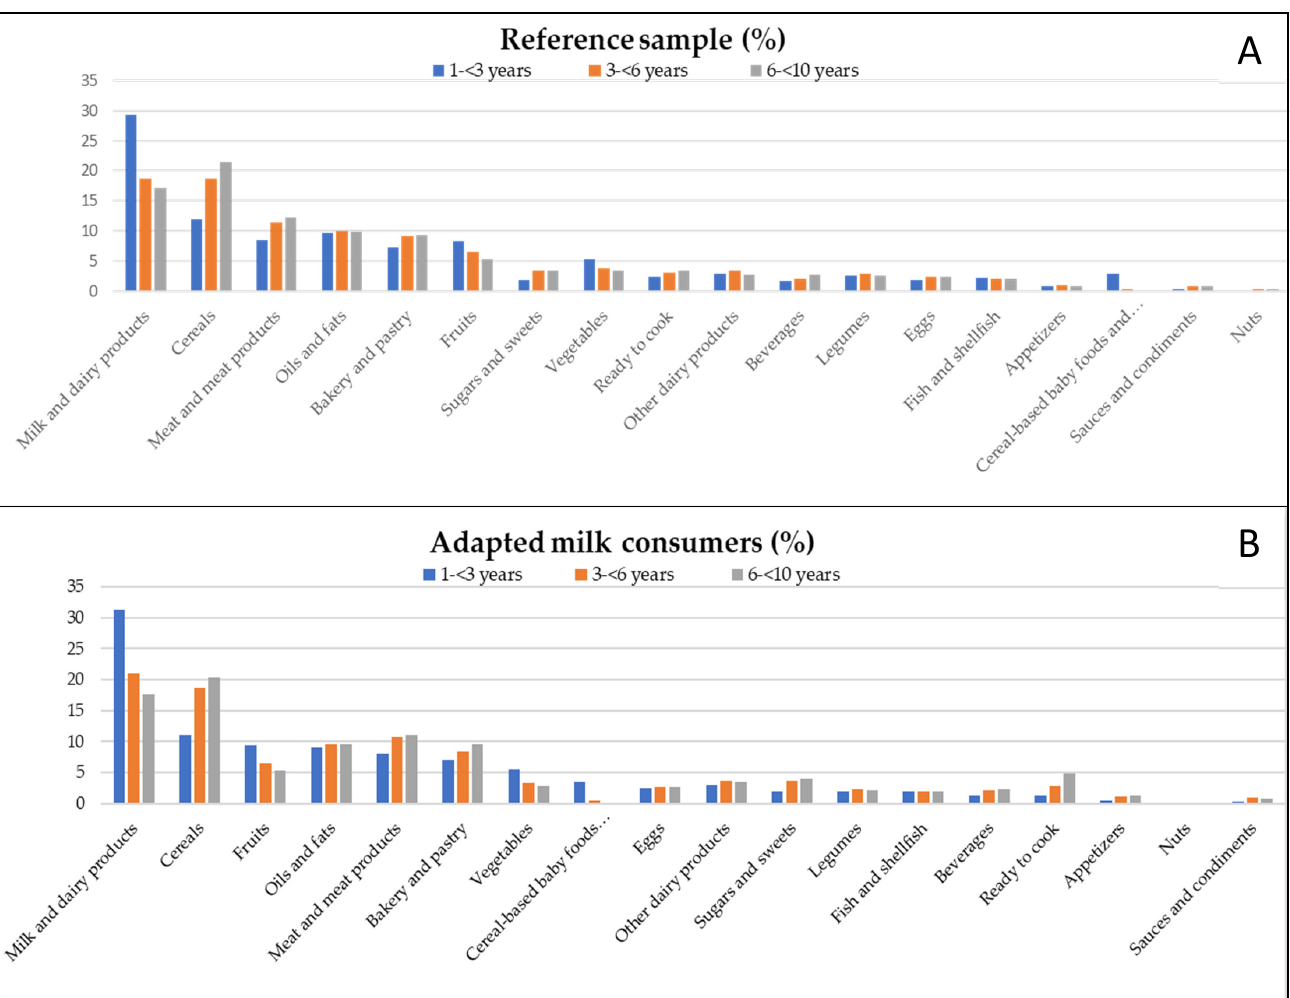
Figure 2. Percentage of the 18 food groups sources of the total energy intake (in %) among Spanish Pediatric Population (EsNuPI) study by age group: ( A ) shows the reference sample and ( B ) the adapted milk consumers sample.